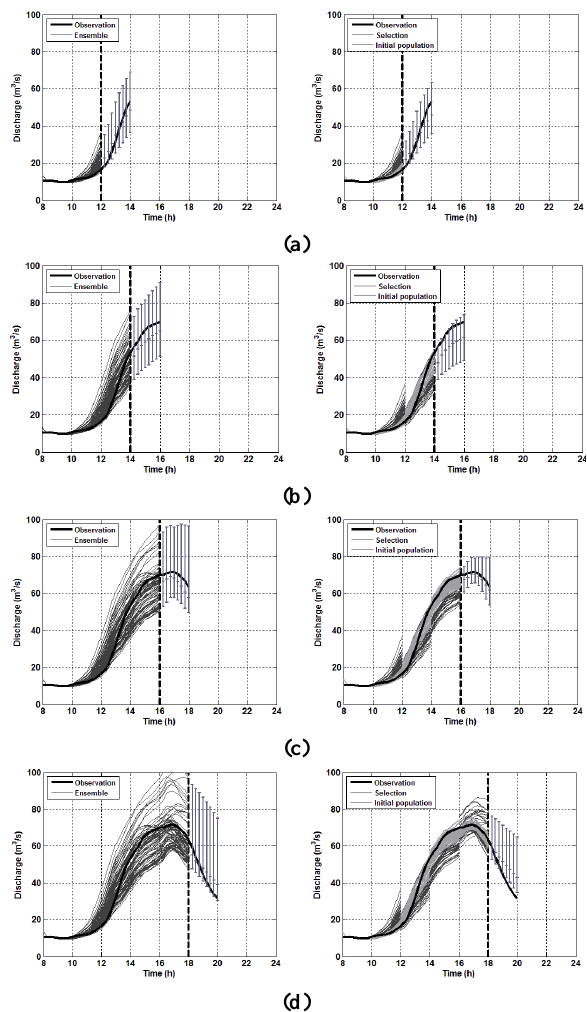
Figure 7. Results of the forecast models for the February 2004 flood event. The vertical 5 Fig. 7. Results of the forecast models for the February 2004 flood dashed line is the current time step. Forecasts are expressed by the median and the prediction 6 event. The vertical dashed line is the current time step. Forecasts limits for a confidence level of 5%.The first column shows the results of the forecast model 7 are expressed by the median and the prediction limits for a confi- without data assimilation and the second column the forecast model with data assimilation. 8 dence level of 5%.The first column shows the results of the forecast model without data assimilation and the second column the forecast The rows show forecasts by current time step: a) t=12 hours; b) t=14 hours; c) t=16 hours; d) 9 model with data assimilation. The rows show forecasts by current t=18 hours. 10 time step: (a) t = 12h; (b) t = 14h; (c) t = 16h; (d) t =